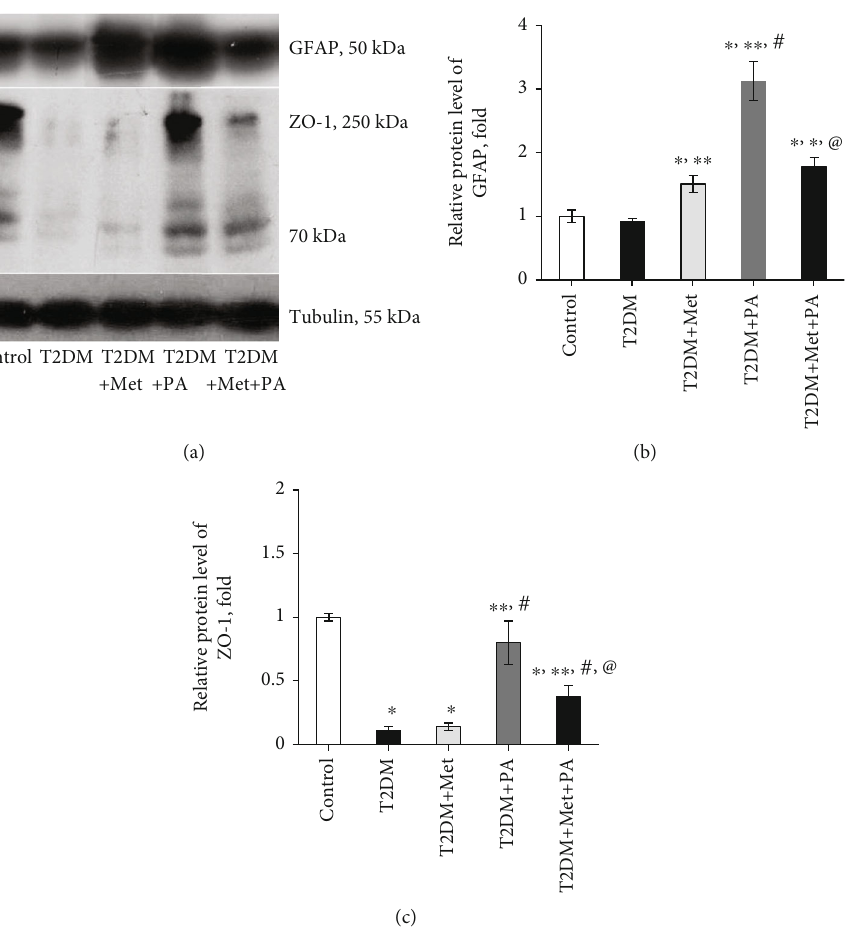
Figure 9: Metformin and PA in fl uence on the level of astrocytic marker GFAP and tight junction protein ZO-1. Immunoblotting analysis of GFAP and ZO-1 in rat VMH: (a) representative immunoblots are shown and quanti fi ed using tubulin as a loading control for hypothalamus lysates. The bar graphs of (b) GFAP and (c) ZO-1 protein levels are presented as means ± SEM (n =6/group). Data are shown as means ± SEM ; ∗ p < 0 : 05 vs. control, ∗∗ p < 0 : 05 vs. T2DM, # p < 0 : 05 vs. metformin administration, and @ p < 0 : 05 vs. PA